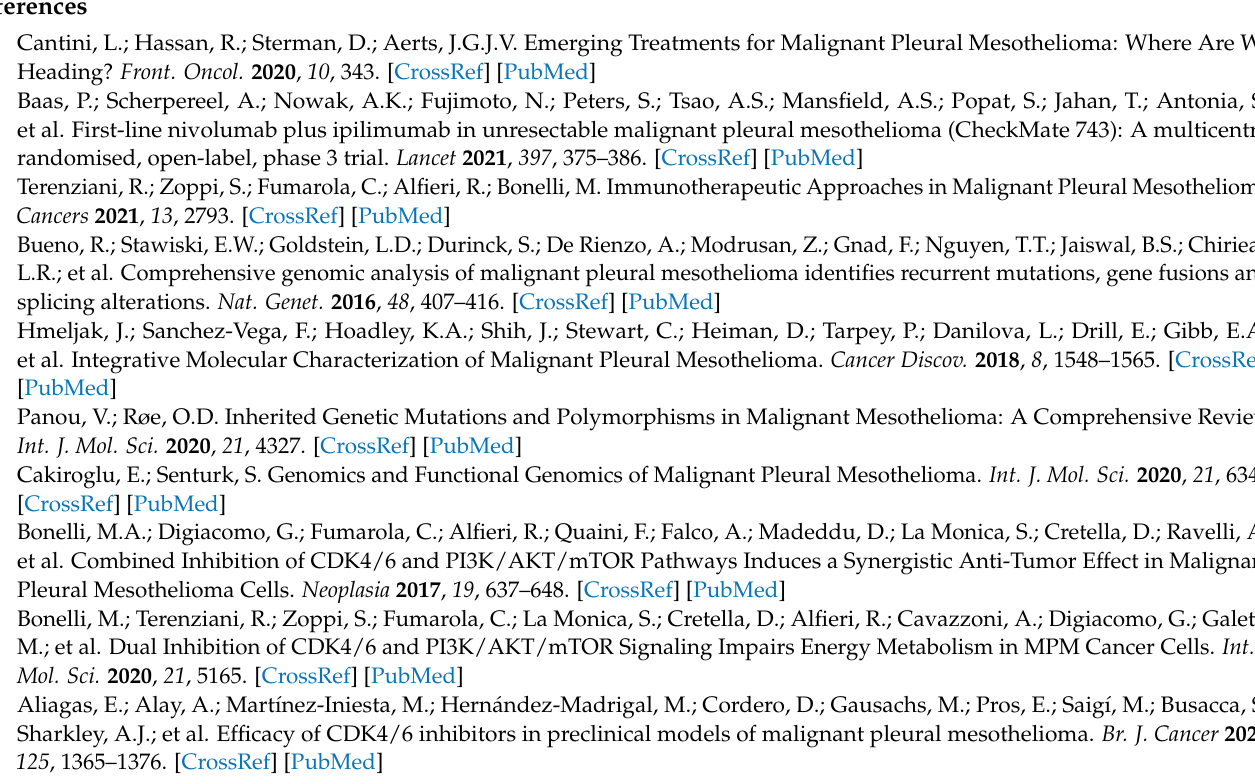
Figure S3: Effects of abemaciclib combined with cisplatin and pemetrexed on colony formation in MSTO-211H cells; Figure S4: Analysis of cell death by Annexin V/PI staining assay in H28 cells; Figure S5: Whole Western blots of Figure 2; Figure S6: Whole Western blots of Figure 4; Figure S7: Whole Western blots of Figure